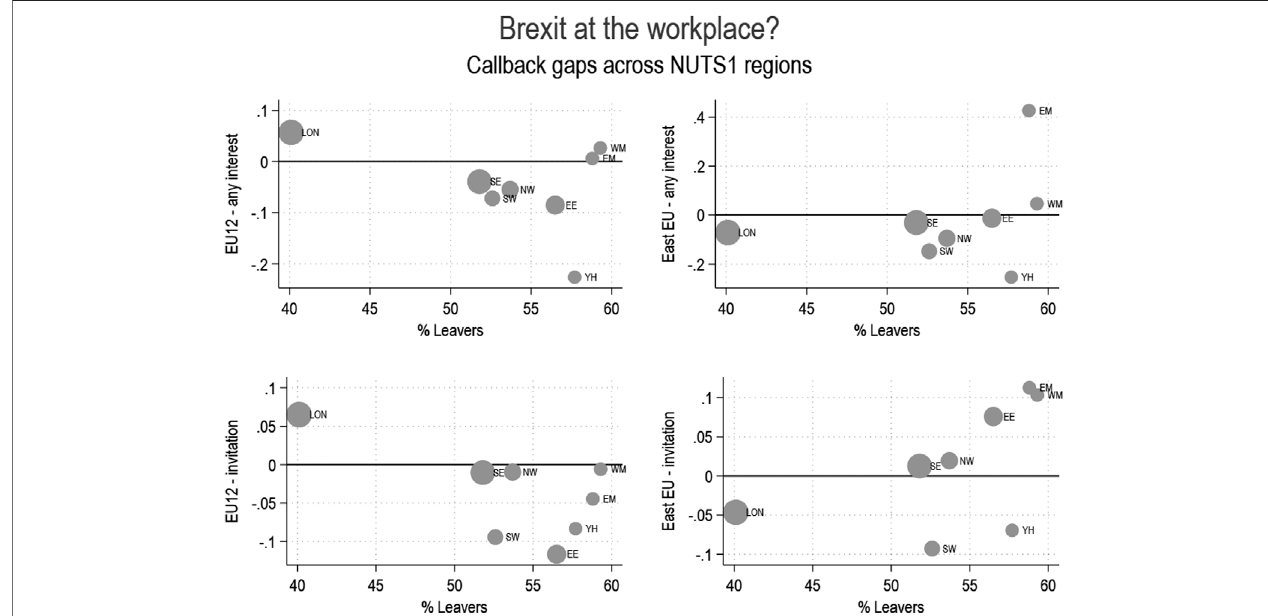
FIGURE 1 | Discrimination and the Brexit vote.